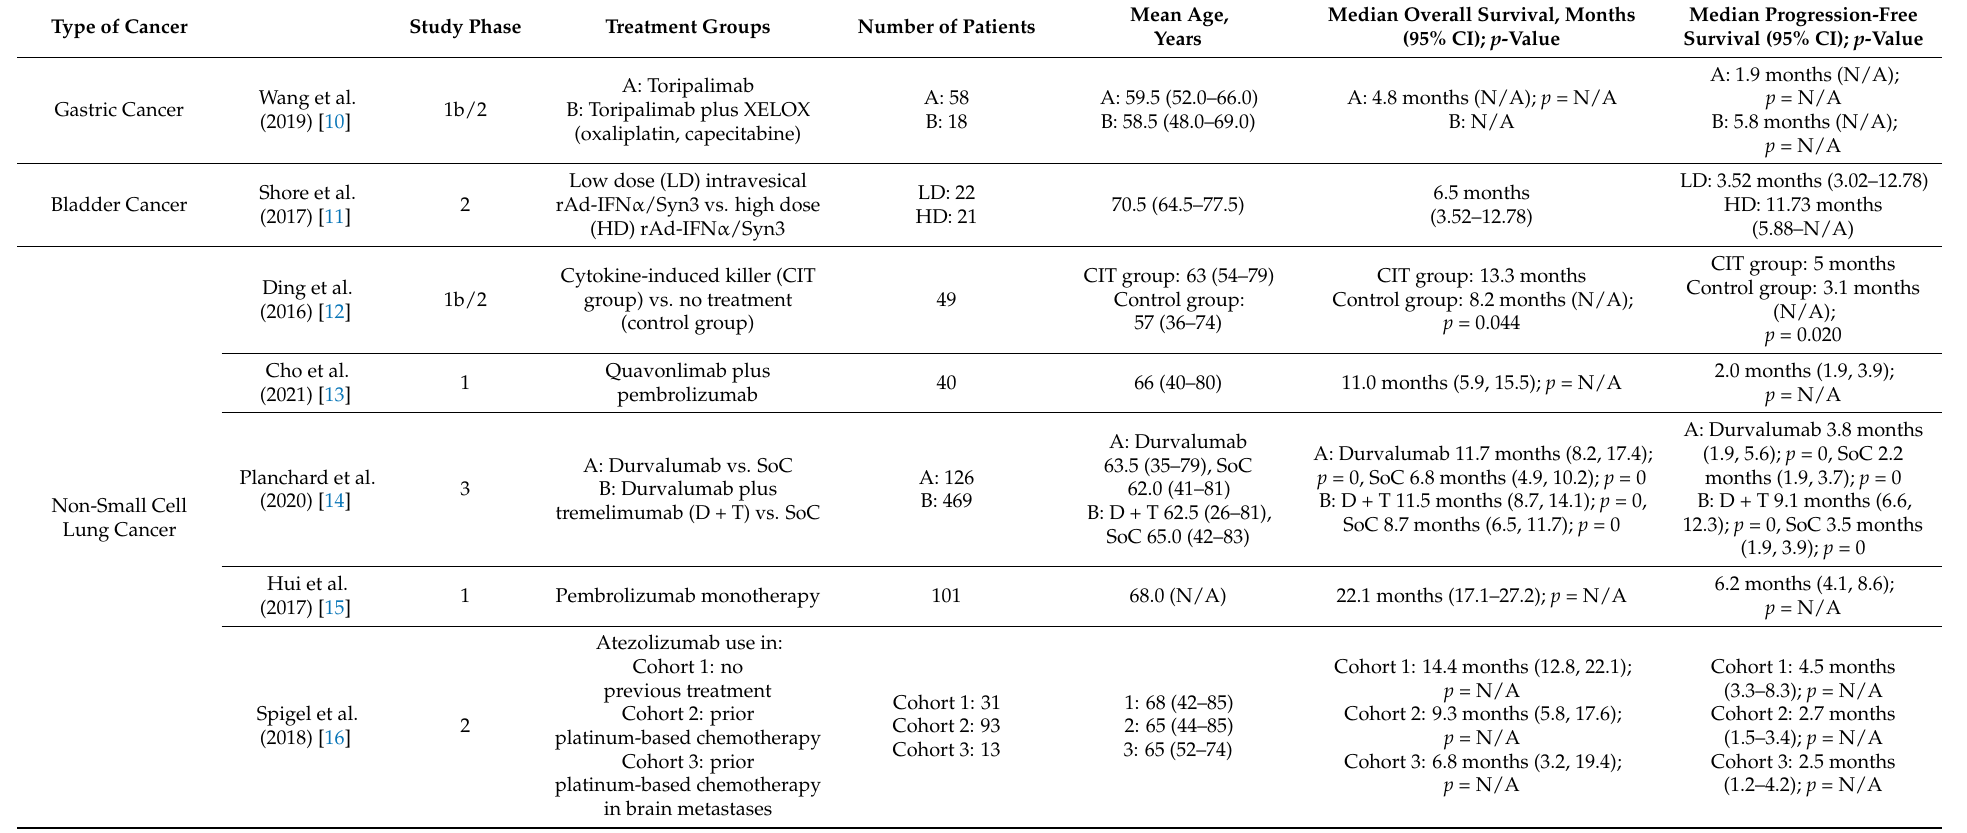
Table 1. The main characteristics and results of the studies are included in the systematic